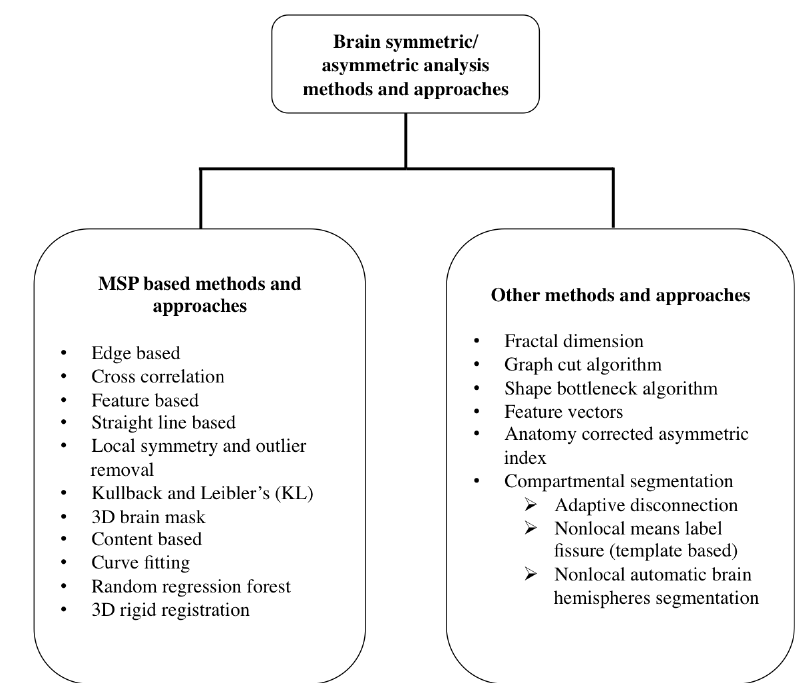
Figure 2. Classification of brain symmetric/asymmetric analysis methods and